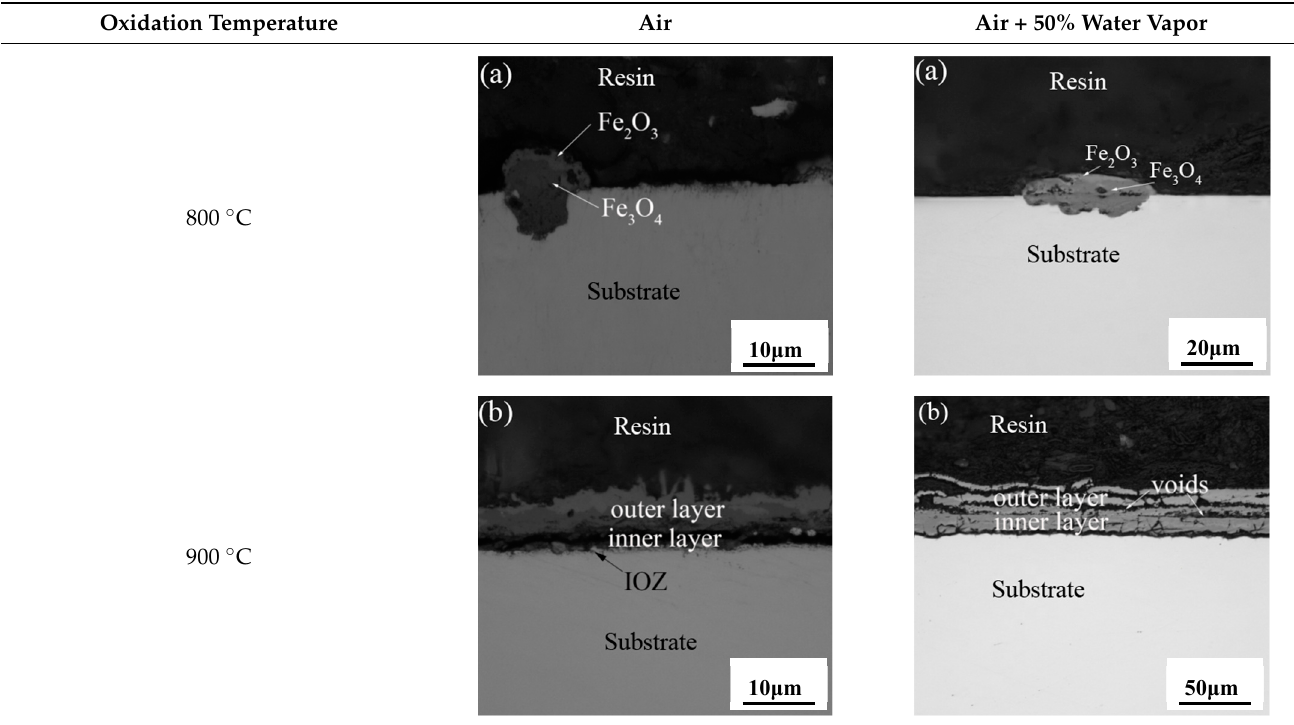
Figure 3. XRD patterns of Fe–10Cr steel in 50% water vapor. ( a ) 800 °C; ( b ) 900 °C; ( c ) 1000 °C; ( d ) 1100 °C; ( e ) 1200 °C. Table 3. Cross-sectional morphology of Fe–10Cr steel oxidized in different atmospheres.